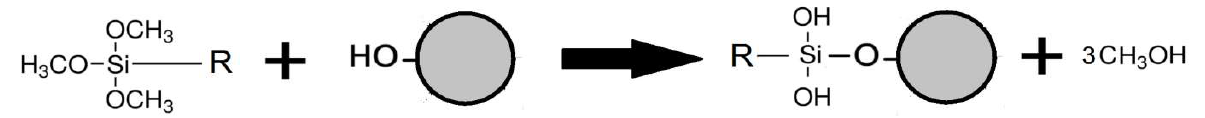
Figure 1. Scheme of binding functional groups onto the surface of alumina nanofibers.